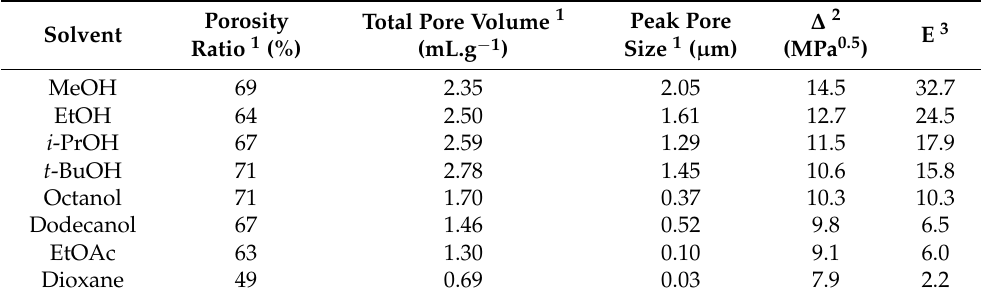
Table 1. Porous features of monoporous VMA-based networks synthesized using various solvents as porogenic agents. The VMA/EGDMA molar ratio was fixed at 70/30 mol.% and the volume ratio of co-monomers/solvent was equal to 20/80 vol.%.